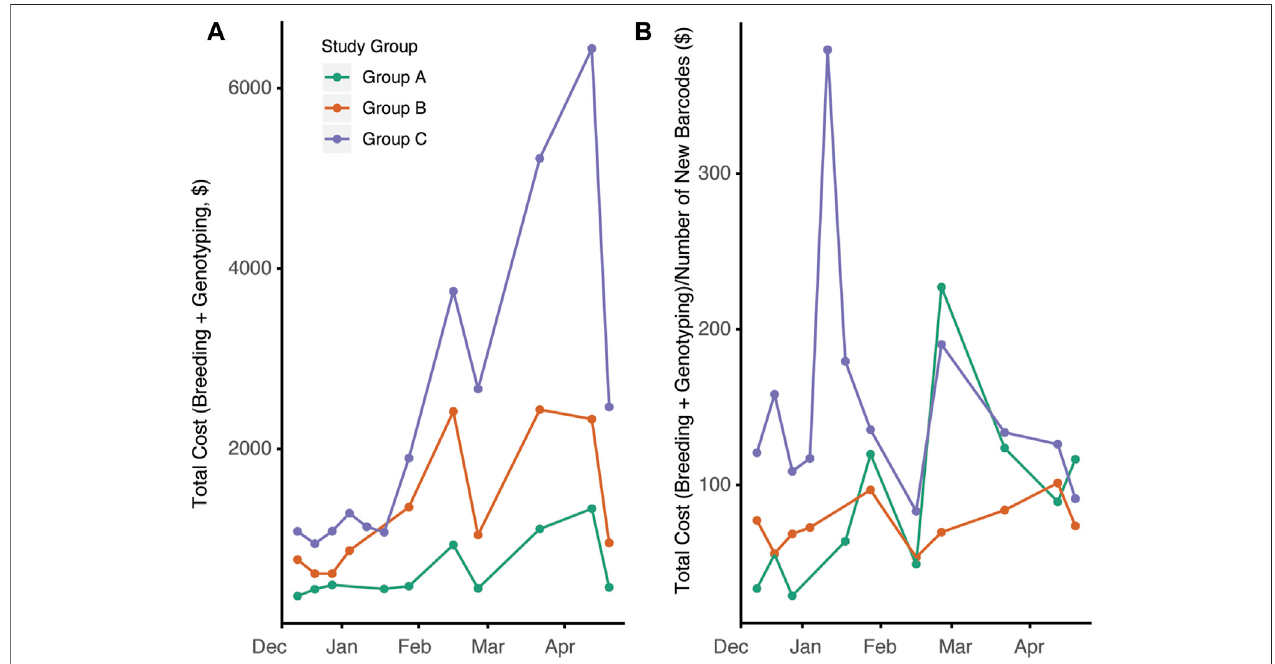
FIGURE5| Breedingmanagementandautomatedgenotyping strategyimpactsoverallcostef fi ciencyofmouse production. (A) Totalcostforeach daycalculated consisting oftotal perdiem costs per2-week intervalplus genotyping cost associated withnewmouseproduction duringthattime frame( p =0.00014) (B) Ratio oftotal costs to census new cage generated (new barcodes) over time for the three groups ( p = 0.784,0.0135)